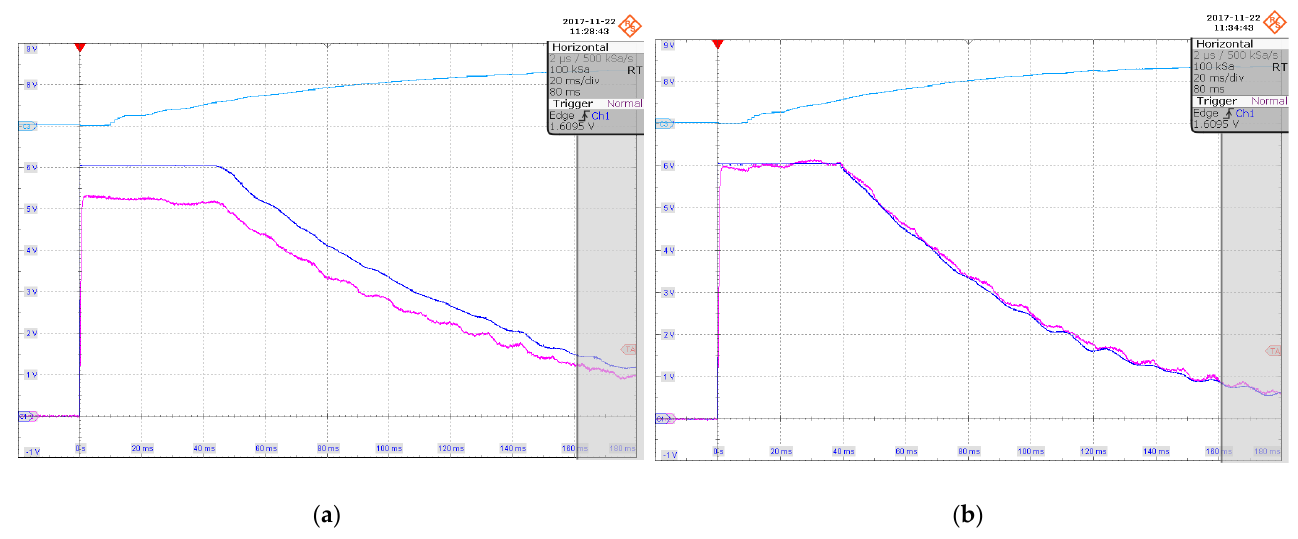
Figure 12. Experimental results: detail of acceleration from 0 to 500 rpm, actual rotor speed (light blue), the reference (dark blue) and actual (pink) torque-producing stator current, total moment of inertia of J t = J M = 0.013 kgm 2 (induction motor only), current scale 1 A/div, speed scale 400 rpm/div, time scale 20 ms/div; ( a ) without decoupling; ( b ) with decoupling.